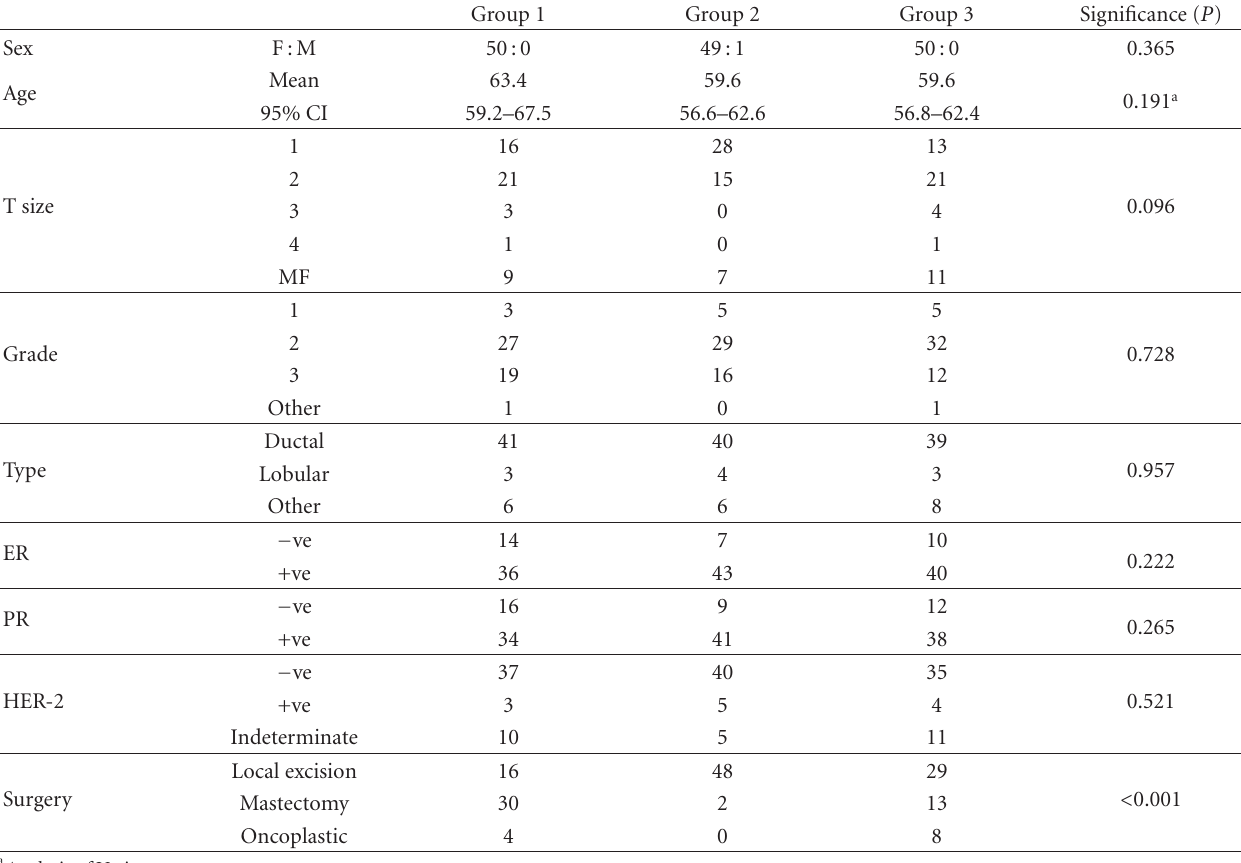
Table 1: Clinicopathological Features. Clinico-pathological features for the three cohorts examined. Age was analysed using Analysis of Variance (ANOVA), other parameters using Pearson’s Chi-Squared test. Group classification of patients by axillary procedure: group 1: primary axillary clearance; group 2: SLNB and dALND; group 3: SLNB and iALND.